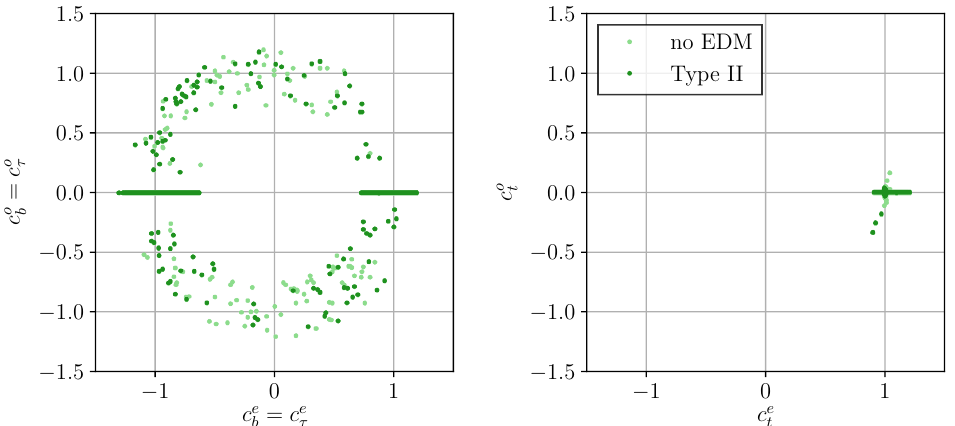
Figure 4 . C2HDM Type II, h (right) for sample 1 (dark) and sample 2